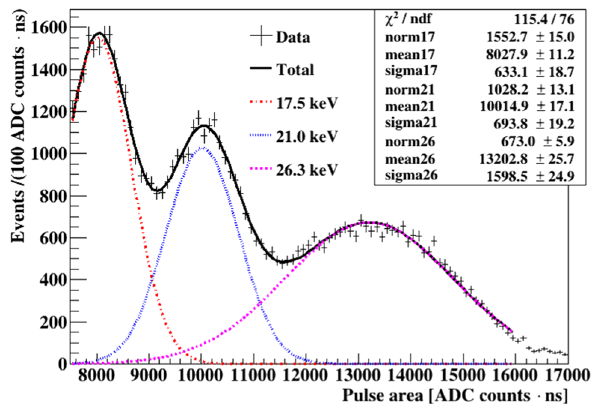
Fig. 8 Simultaneous fitting of the 17.5, 21.0 keV X-ray and 26.3 keV γ -ray peaks with three Gaussian functions